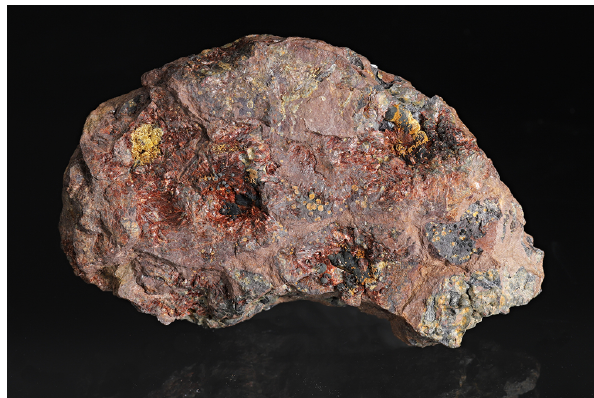
Figure 4. Neotype specimen of beraunite from the Hrbek Mine, Svatá Dobrotivá (St. Benigna), Beroun, Bohemia, Czech Repub- lic. National Museum Prague, P1N 18943 (sampleNM). 8 × 5cm. Photo L. Vrtiška.